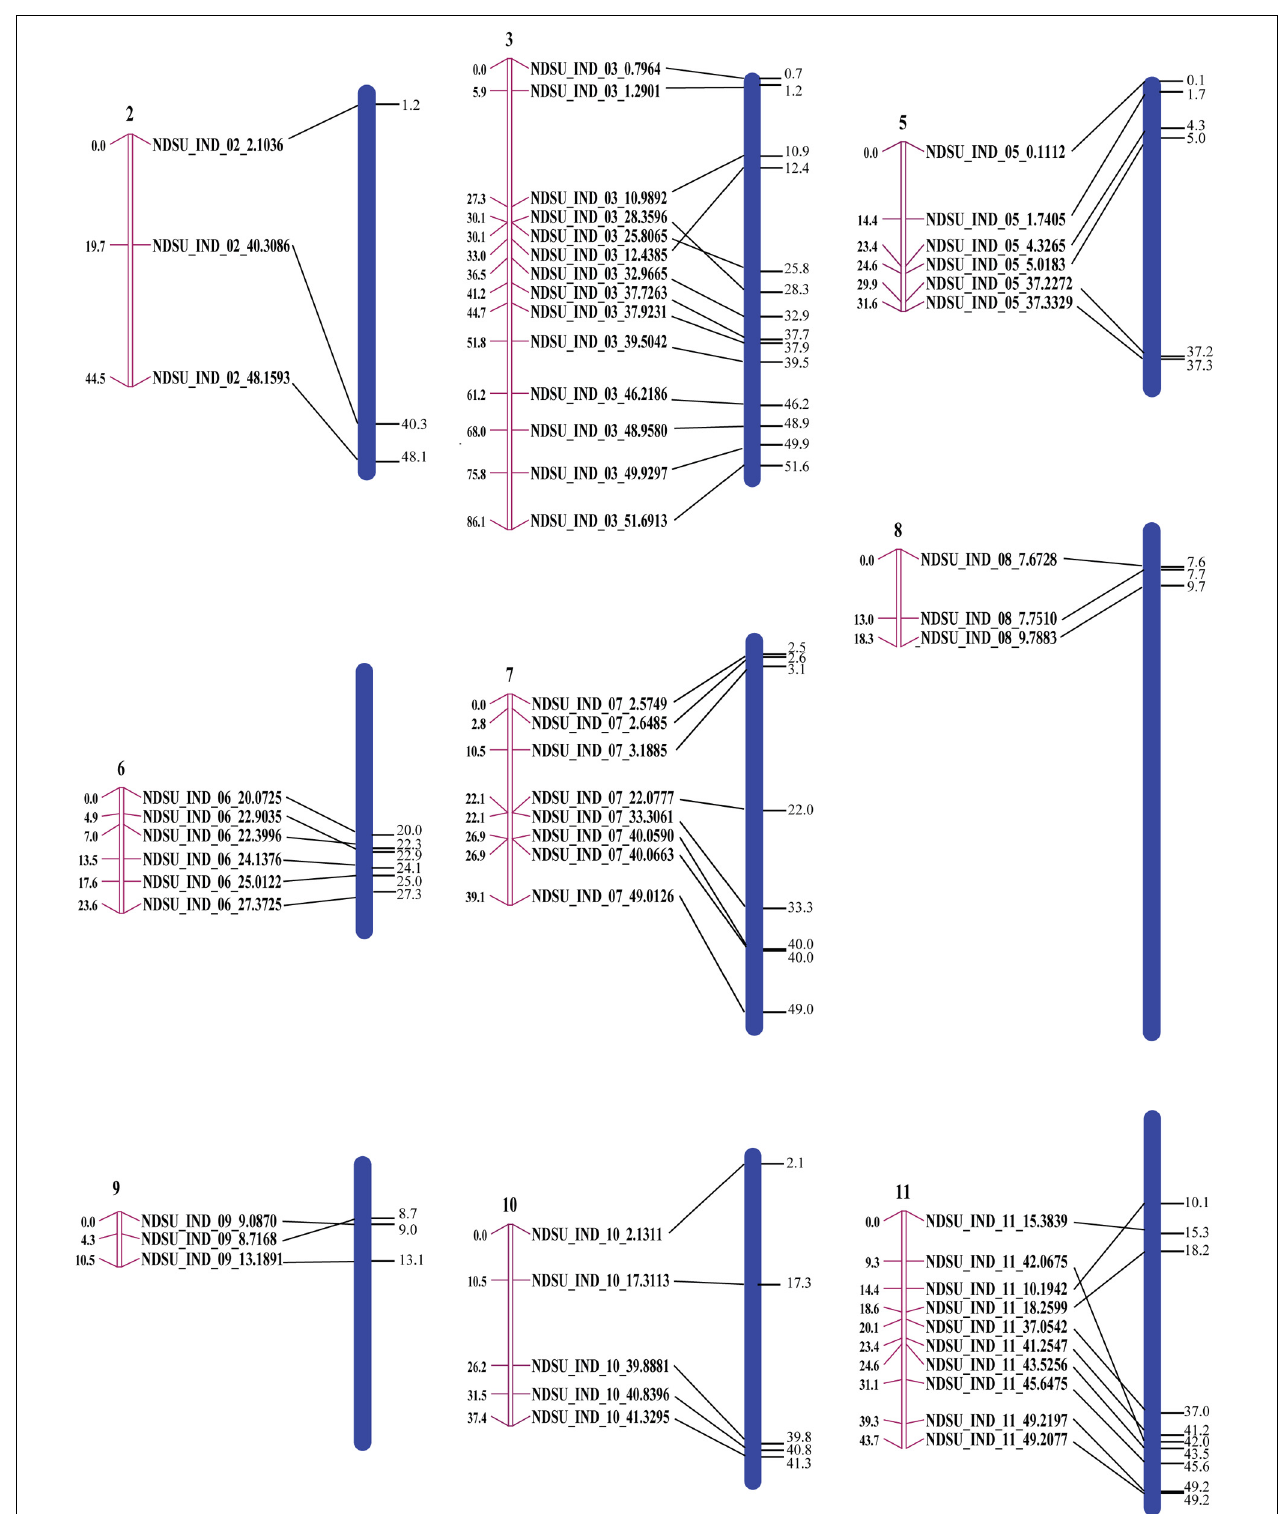
FIGURE 5 | Correspondence between genetic and physical positions. The pink bars are linkage groups and the blue bars are the chromosomes with the physical positions of the InDel markers on their right side. The sizes of the chromosomes are proportional to their actual size.